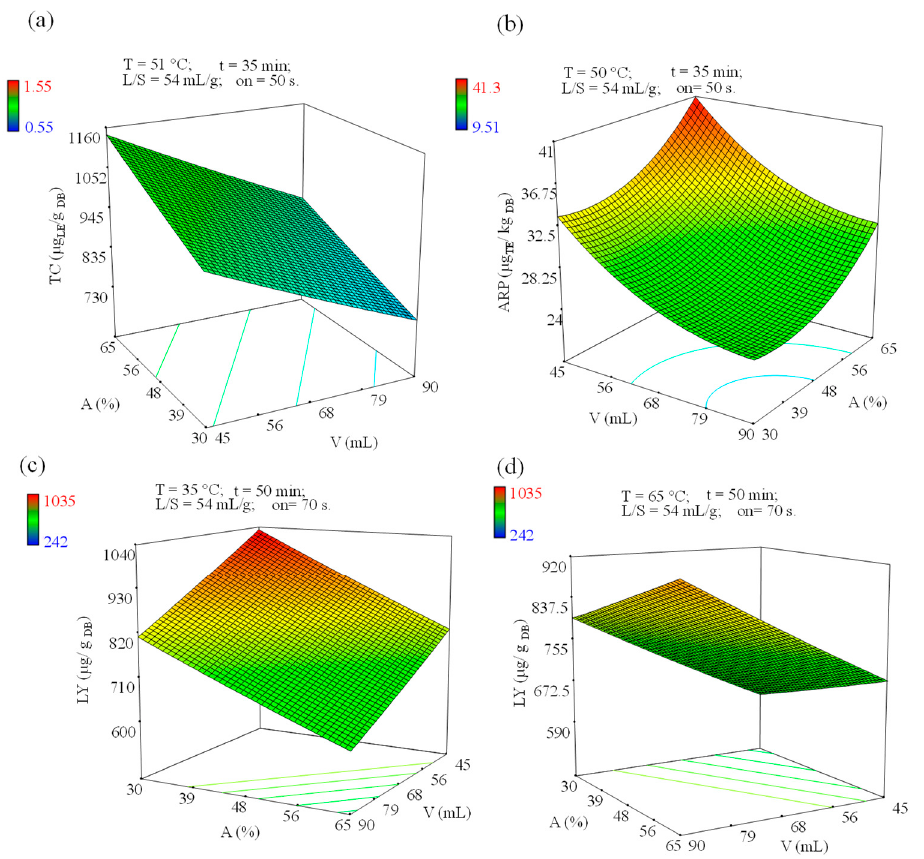
Figure 3. Surface plots of: ( a ) total carotenoid yield ( TC ); ( b ) antiradical power ( ARP ); and ( c , d ) lycopene yield as functions of amplitude ( A ) and total volume ( V ).